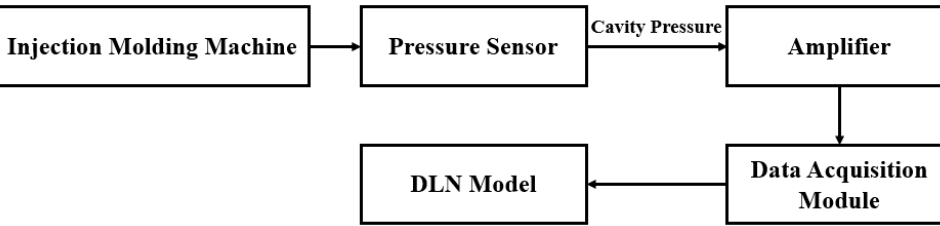
Figure 7. Flow chart of bumper quality inspection system.